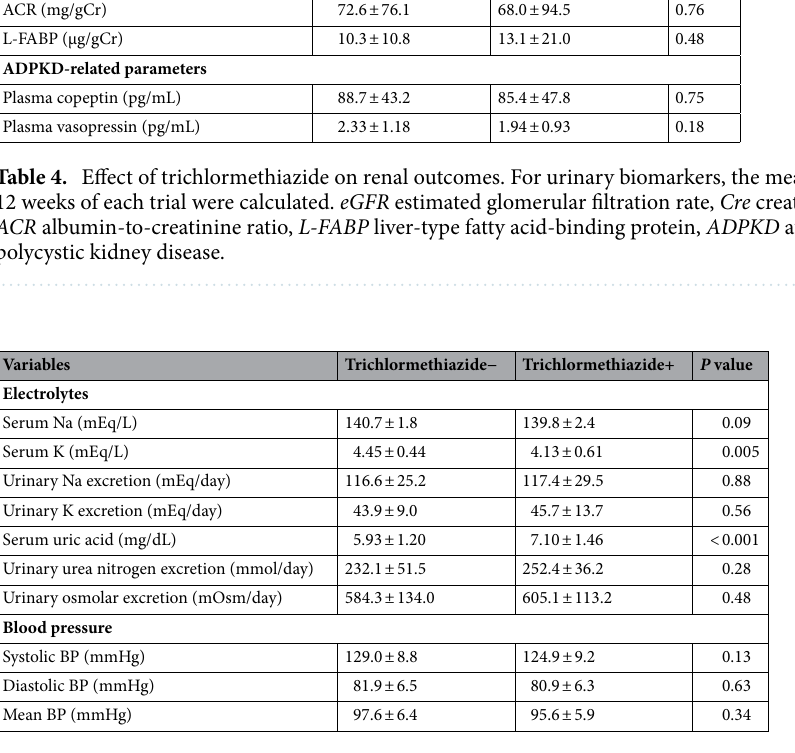
Table 5. Effect of trichlormethiazide on serum and urinary electrolytes; serum uric acid, urinary urea nitrogen, and osmolar excretion; and blood pressure. For these variables, the mean values at 4, 8, and 12 weeks of each trial were calculated. Na sodium, K potassium, BP blood